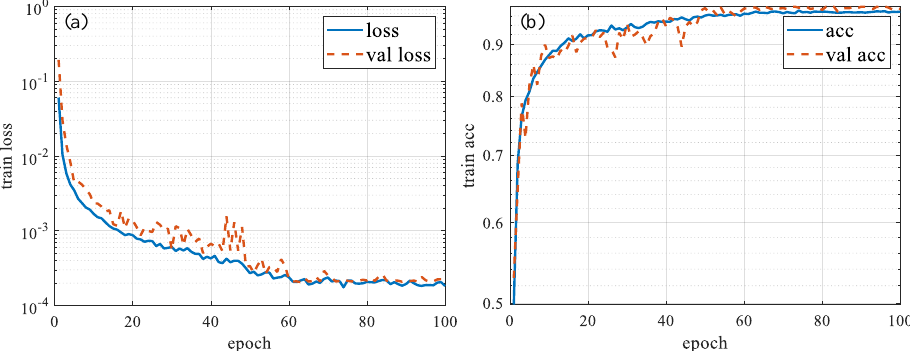
Figure 5. Loss function and accuracy of the model: ( a ) network loss function; ( b ) network accuracy.